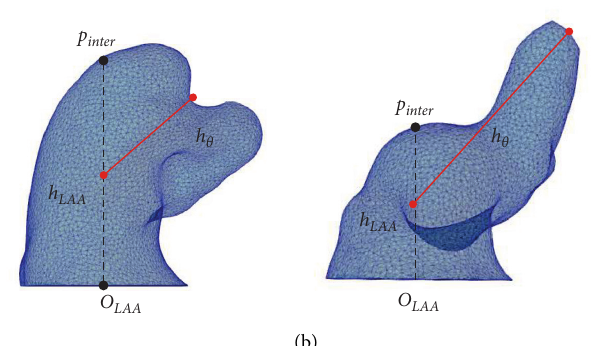
Figure 2: (a) Left atrial appendage division in three regions for the haemodynamic analysis (left) and morphological indices: ostium perimeter (p ostium ) and area (A ostium ), neck height (h LAA ), distal point length ( h θ ), maximum ostium diameter ( D max ), origin of the LAA (O LAA ), intersected point (p inter ), anterior ( d A ) and posterior ( d P ) distance of the LAA and LAA, and centre of mass (p mass ). (b) Examples of LAA with high and low tortuosity (left and right,